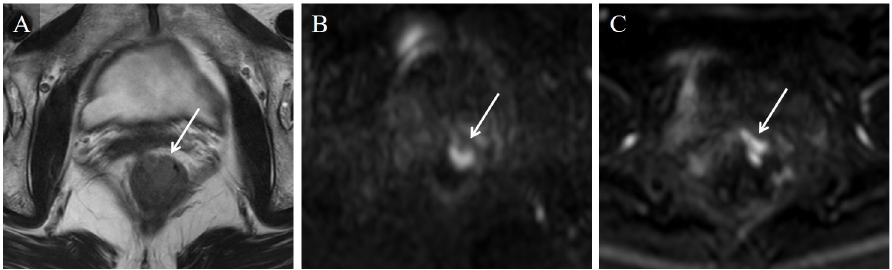
Fig 1. Stage T1 rectal carcinoma in a 75-year-old woman. From the T2WI image (A) alone, all readers misdiagnosed the stage. On the TSE-DWI image (B), an area of high signal intensity with a low signal intensity of stalk was depicted and diagnosed as stage T1. However, this finding was not presented on the EPI-DWI image (C) due to distortion artifacts, and all readers misdiagnosed the stage, as with the T2WI image alone. https://doi.org/10.1371/journal.pone.0249433.g001 TSE-DWI+T2WI, respectively. Poor, poor to slight, and fair to perfect agreements with the pathological T-stage in the 7 cases were observed for T2WI alone, EPI-DWI+T2WI, and TSE-DWI+T2WI, respectively (kappa = 0–0.07, 0–0.22, and 0.60–1, respectively). Representa- tive pathologically-proven cases are presented in Figs 1–3. Table 5 shows the distribution of T- stages diagnosed with the MRI images by the readers for respective pathologically proven T- stages. For pathologically proven T1 stage (Fig 1), 9 readers diagnosed the accurate T-stage on TSE-DWI+T2WI, but all readers misdiagnosed on T2WI alone and EPI-DWI+T2WI. For pathologically proven T3 stage, diagnoses by the readers were more miscellaneous for T2WI alone and EPI-DWI+T2WI compared to TSE-DWI+T2WI, although the accurate diagnosis might not have been difficult in some cases, (e.g., case in Fig 2). For pathologically proven T2 stage (Fig 3), all readers misdiagnosed with T2WI alone and EPI-DWI+T2WI and diagnosed as either T2 or T3 with TSE-DWI+T2WI.